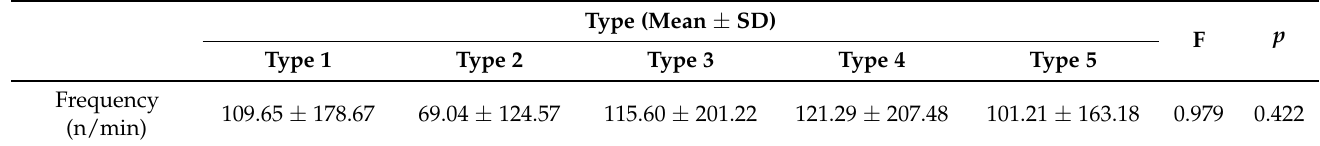
Table 25. Welch ANOVA of eye movement frequency of different size